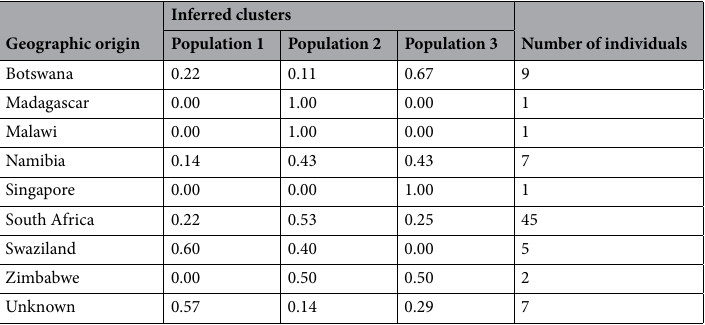
Table 5. Genetic contribution of 78 Bambara groundnut landraces from the geographic origins in three populations as detected by structure